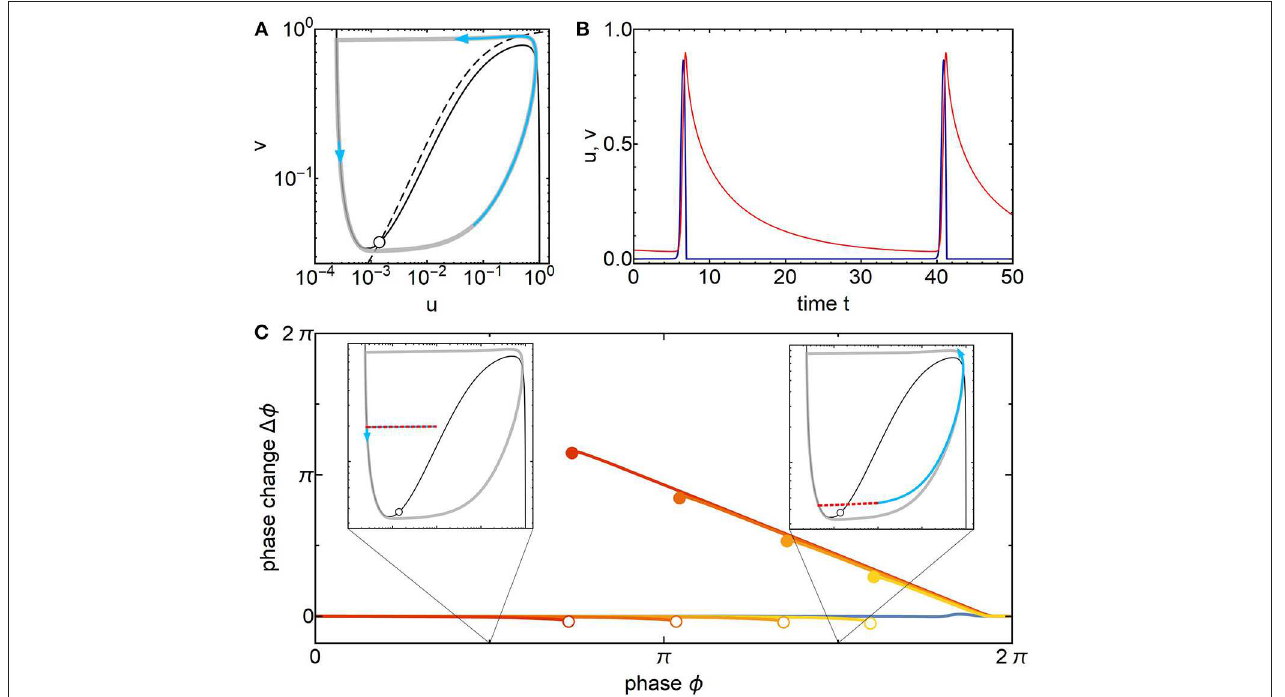
FIGURE 1 | Relaxation oscillator dynamics of the ZBKE model (A) Logarithmically-scaled phase plane consisting of unstable fixed point (empty dot) at the intersection of u- and v-nullclines (continuous, dashed black lines) surrounded by stable limit cycle (gray). Two example trajectories (blue) lasting 3 dimensionless time units illustrate fast and slow dynamics along the limit cycle. (B) Time series of u, v variables (blue, red) exhibit time scale separation that is characteristic for a relaxation oscillation. (C) Phase response curves for different perturbation amplitudes (red to yellow: I p = { 1,1 / 2,1 / 4,1 / 8 } × 10 − 3 , blue: I p = 10 − 5 ). Insets show perturbation (red dashed) and perturbed phase plane trajectories (blue) in phase space underlying the measured phase change 1φ . Parameters: ǫ 1 = 0.11, ǫ 2 = 1.7 × 10 − 5 , ǫ 3 = 1.6 × 10 − 3 , α = 0.1, β = 1.7 × 10 − 5 , γ = 1.2, µ = 2.4 × 10 − 4 , q = 0.7, I 0 = 5.25 × 10 − 4 , natural frequency ω 0 = 0.177, time step 1 t = 2 × 10 − 4